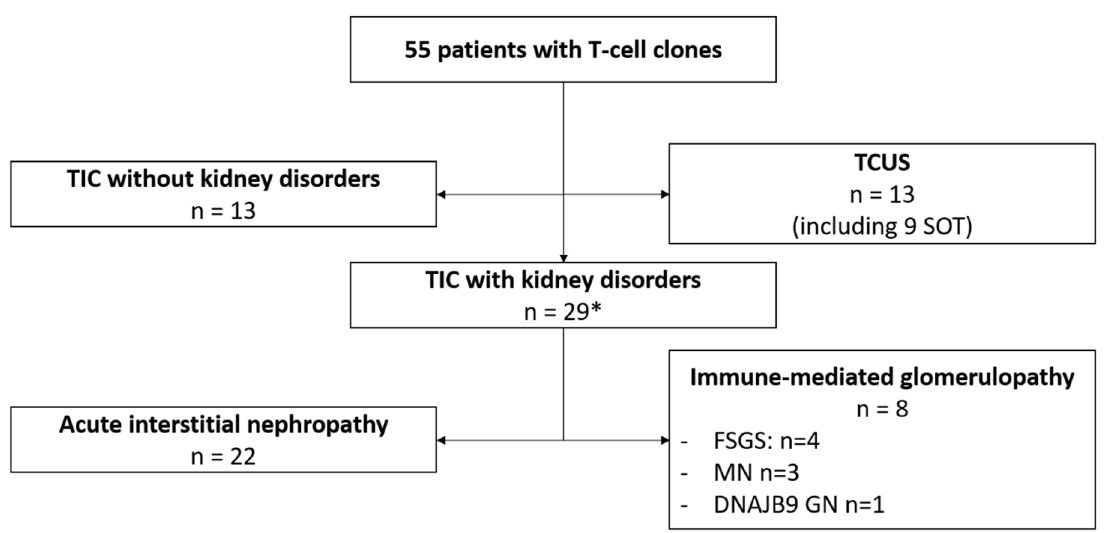
Figure 1. Flow-chart of the study. TIC, T-cell immunoclone; TCUS, T-cell clone of unknown significance; FSGS, focal and segmental glomerulosclerosis; MN, membranous nephropathy; GN, glomerulonephritis.